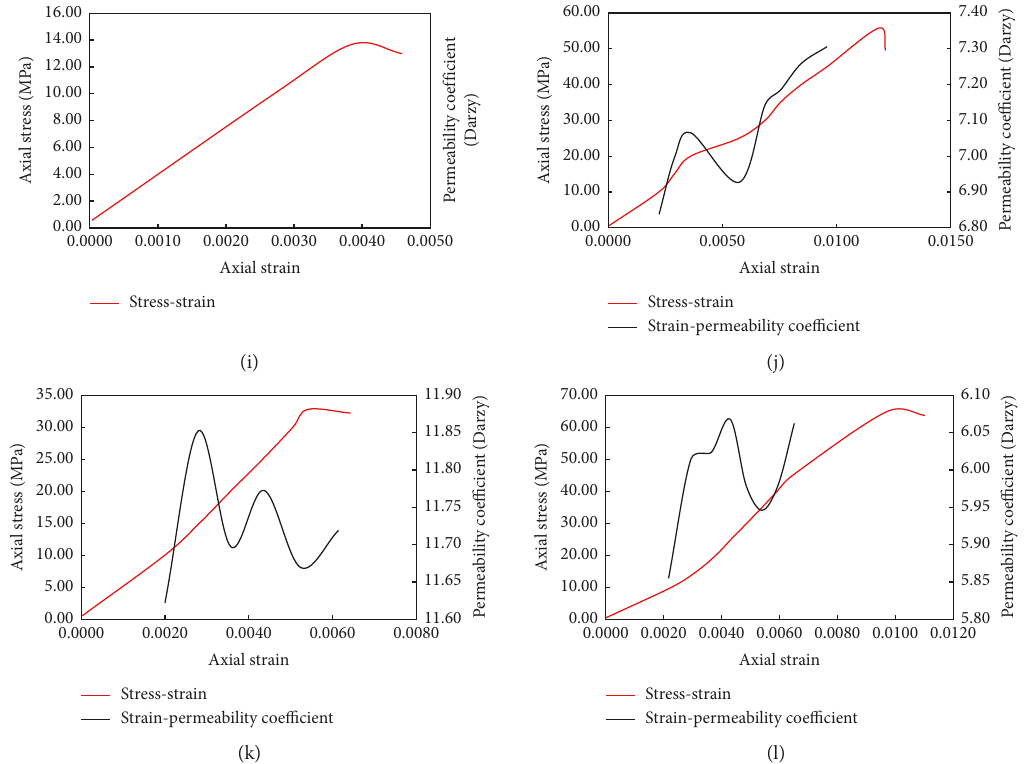
Figure 7: Stress-strain-permeability coefficient curve. (a) Sample 1-1: confining pressure confining